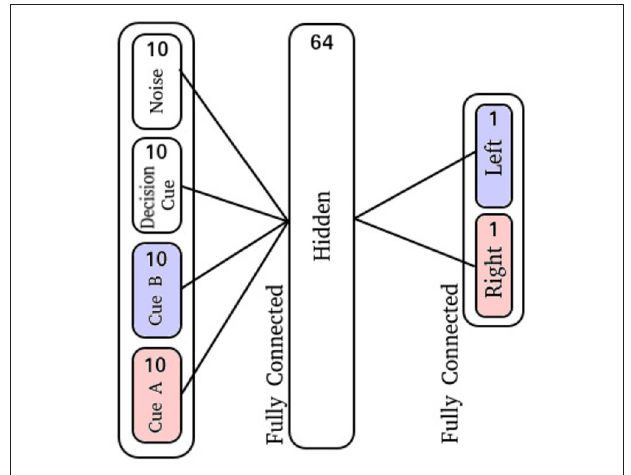
FIGURE 3 | Cue-Association network